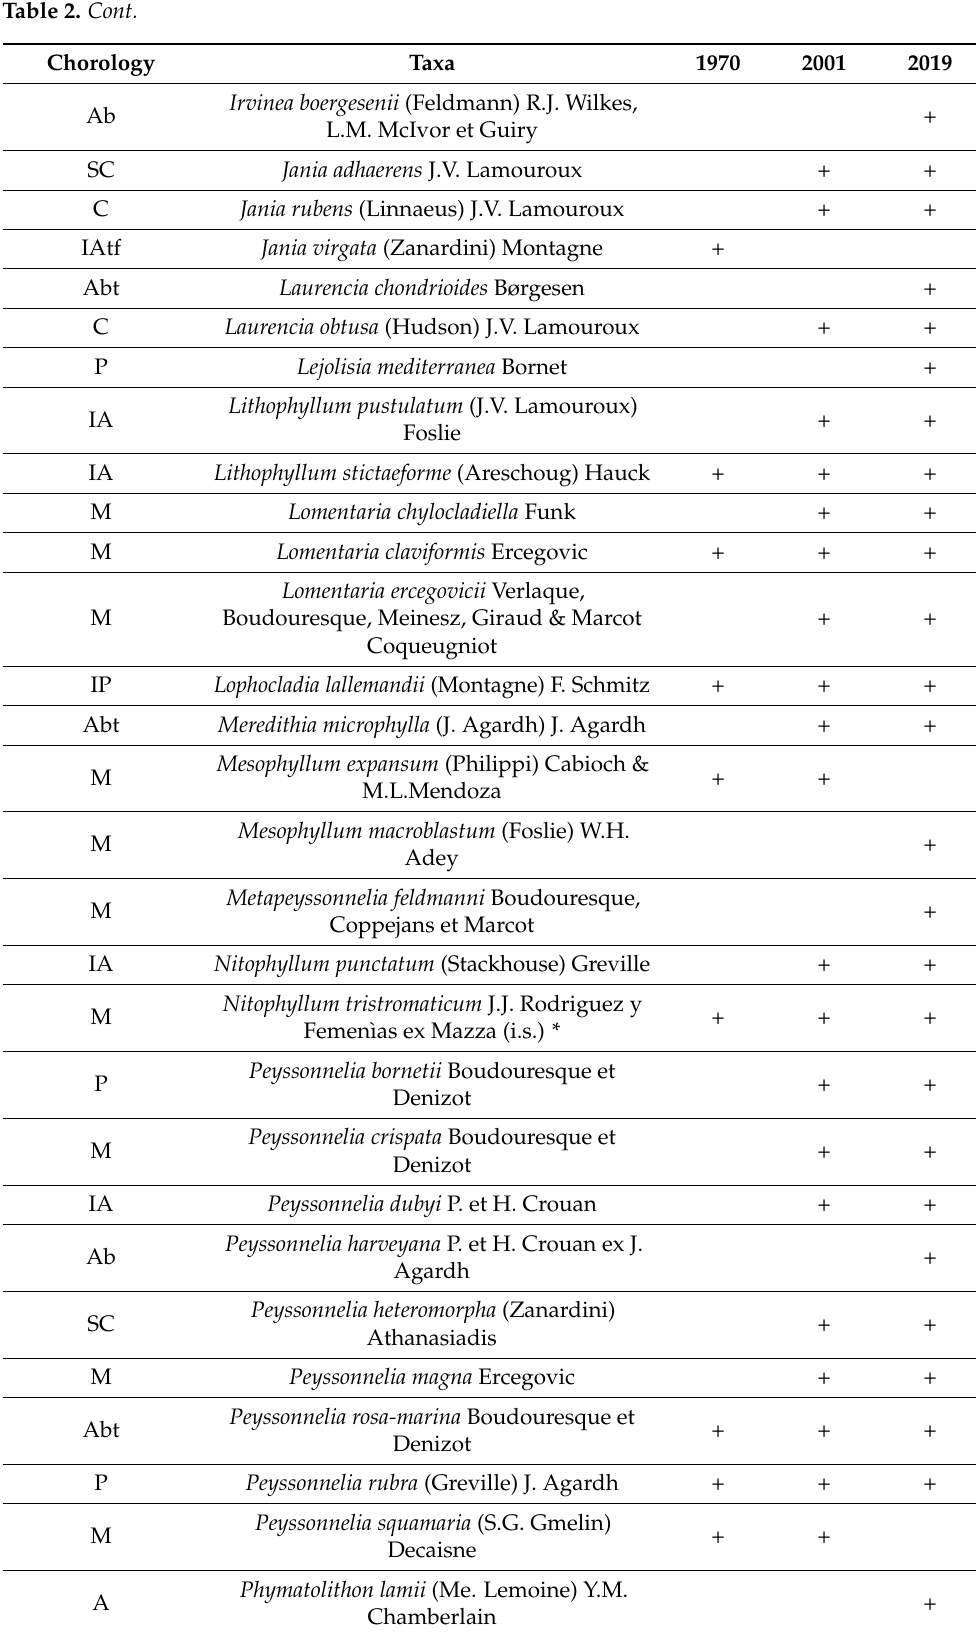
Table 2. Cont. Chorology